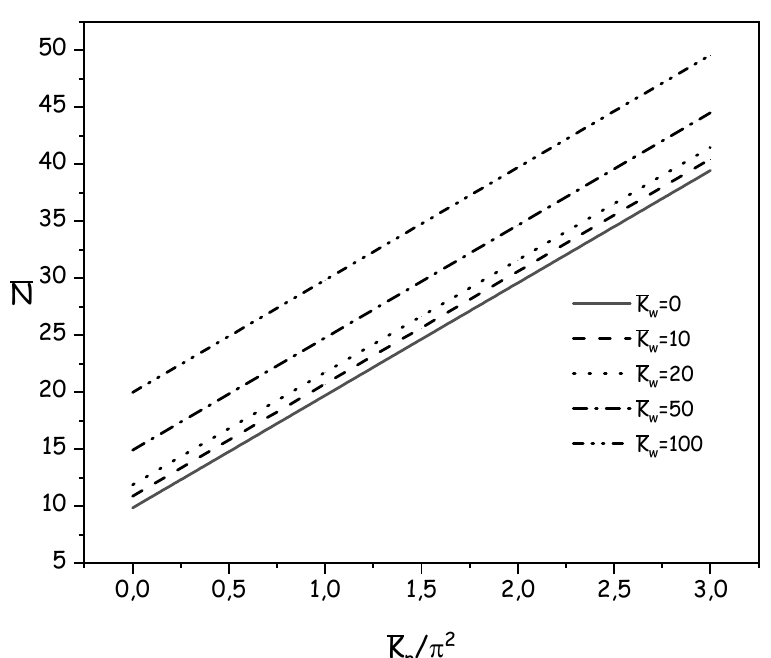
Figure 3: Variation of the non-dimensional buckling load parameter N of an isotropic-homogeneous beam with Pasternak